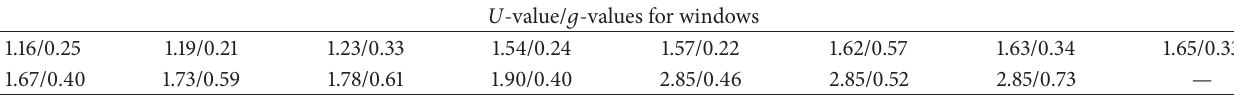
Table 1: U -values and 𝑔 -values (SHGC) for windows. U -value/ 𝑔 -values for